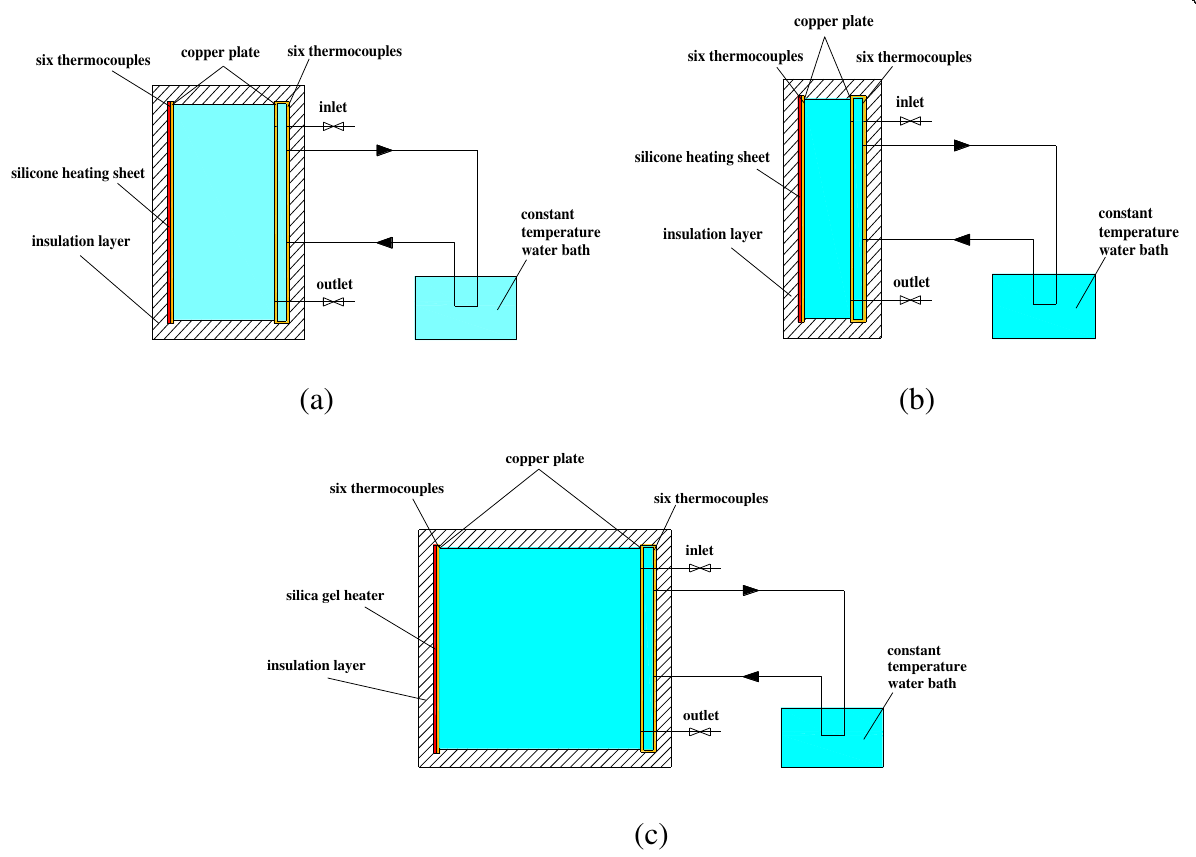
Fig. 5 Schematic diagrams of experimental sets. Schematic diagrams of three different aspect ratio experimental sets. a A =1:2. b A =1:4. c A